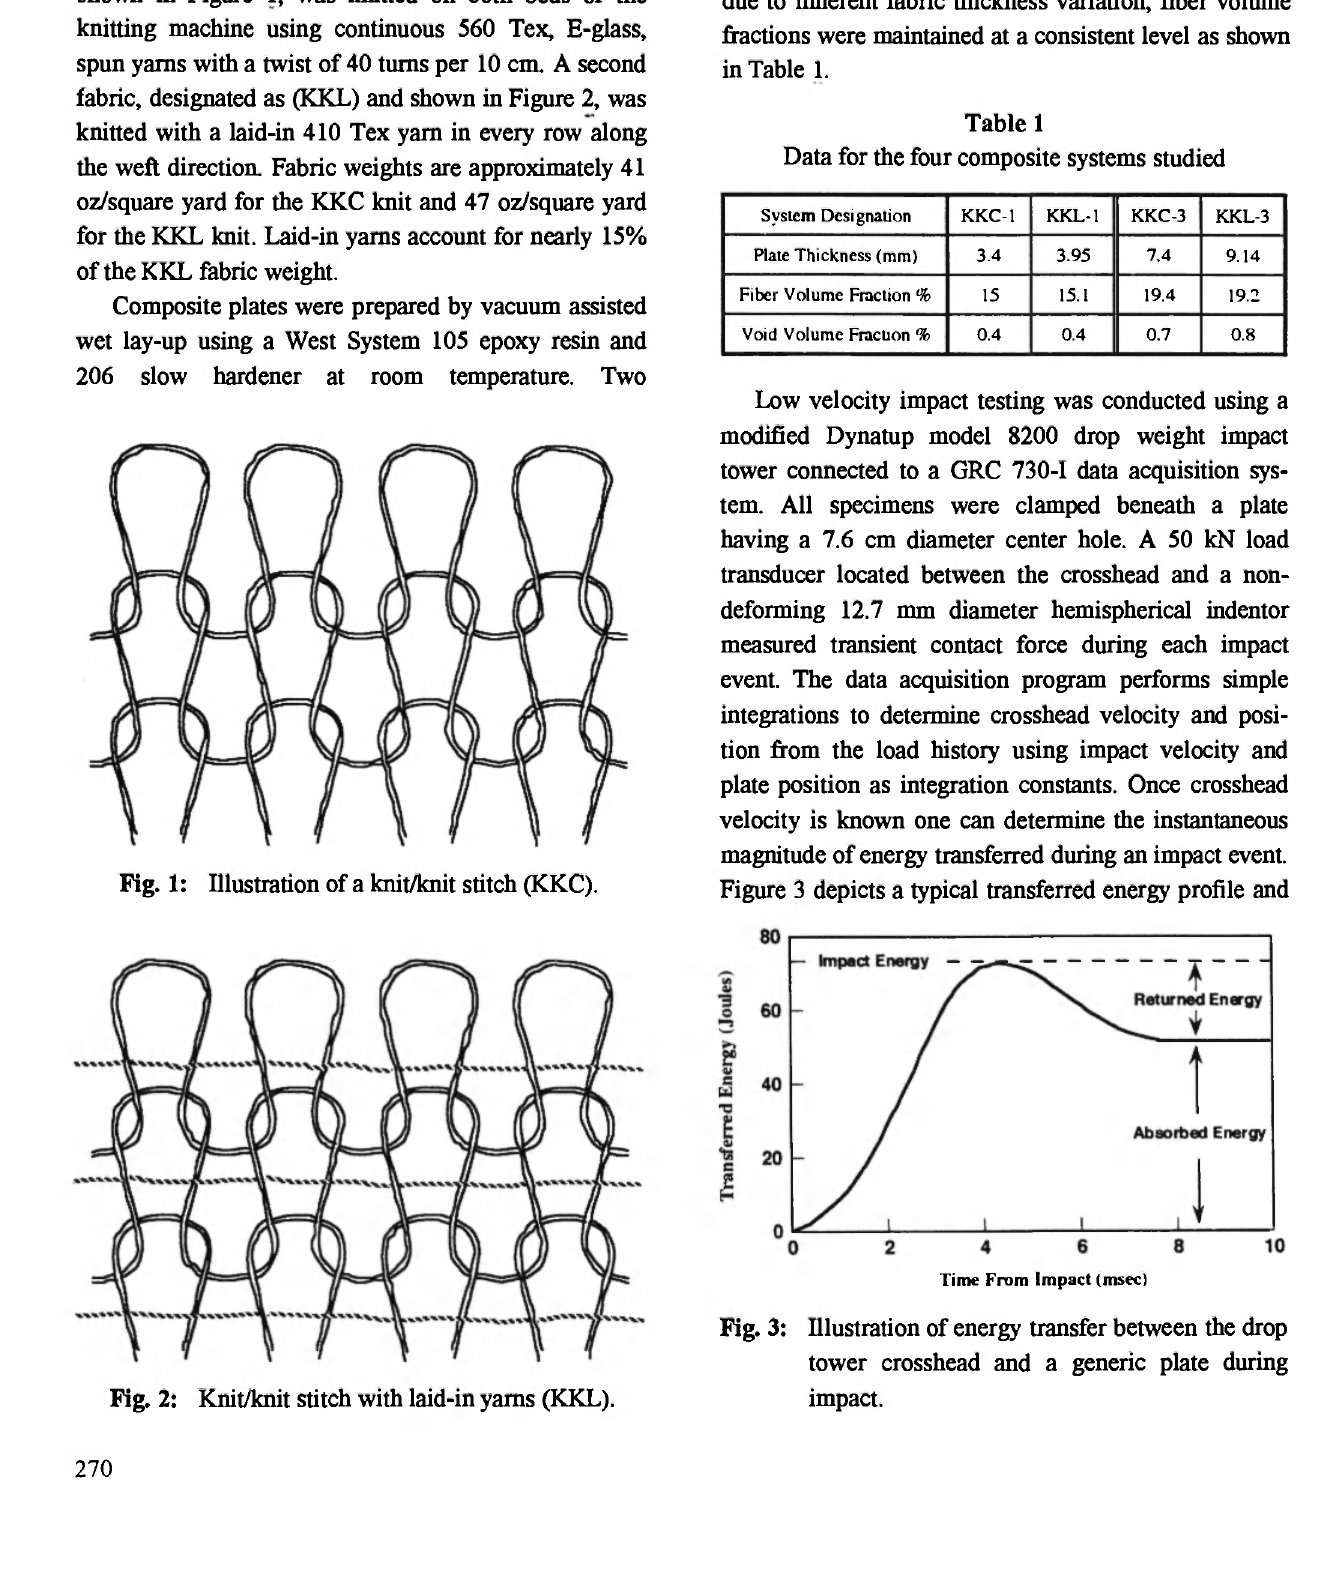
Fig. 2: Knit/knit stitch with laid-in yarns (KKL).